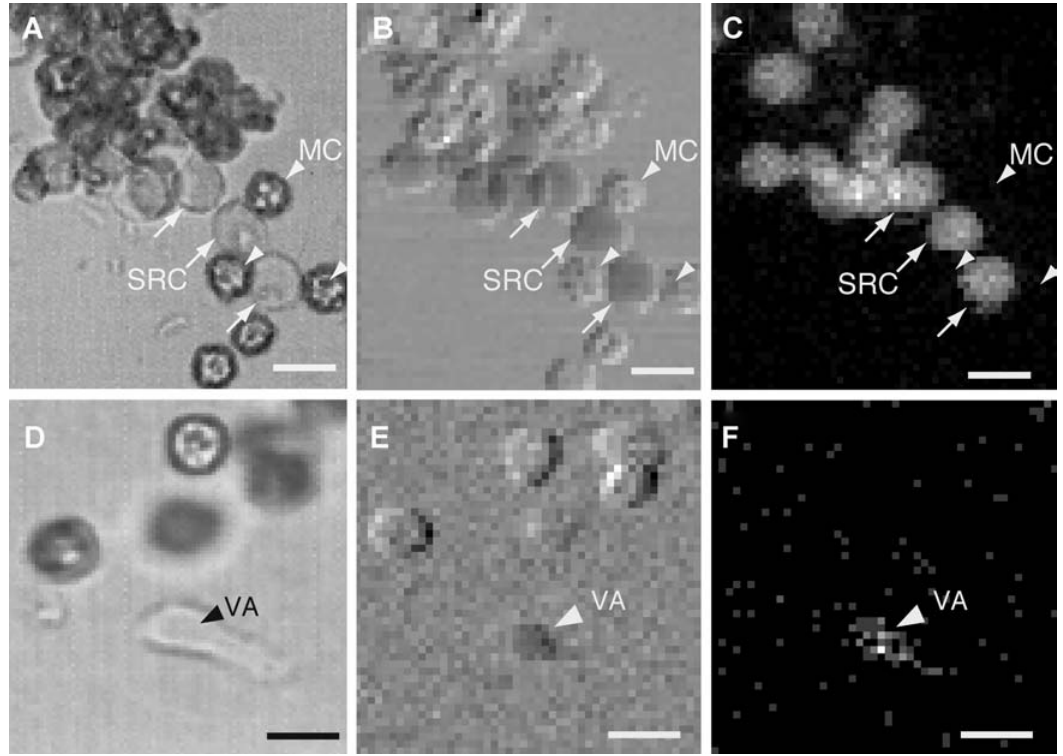
Figure 2 Phallusia mammillata blood cells observed by differential interference contrast optical microscopy (A, D) and X-ray microscopy in the transmission mode (B, E) and fluorescence mode for vanadium (C, F). Photographs (A–C) are from the same field of view; photographs (D–F) are from another field. Vanadium is accumulated in signet ring cells (SRCs, shown by arrows) and a vacuolated amoebocyte (VA, shown by arrowheads in D–F), but not in morula cells (MCs, shown by arrowheads in A–C). Each scale bar s 10 m m. Reproduced from Ref. (47). Copyright 2002 Zoological Society of